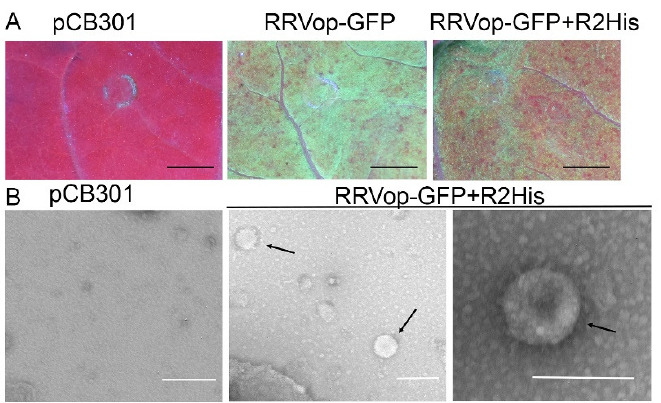
Figure 6. Adding agR2His to RRVop-GFP+2b and detection of virions in infected leaves. ( A ) Fluorescence imaging of N. benthamiana leaves treated with empty plasmid pCB301, RRVop-GFP replicon, or RRVop-GFP plus R2His. Black scale bars represent 1 cm. ( B ) Electron micrographs show mock pCB301 treated extract or virion particles (black arrows) in RRVop-GFP+R2His. White scale bars represent 0.2 microns.